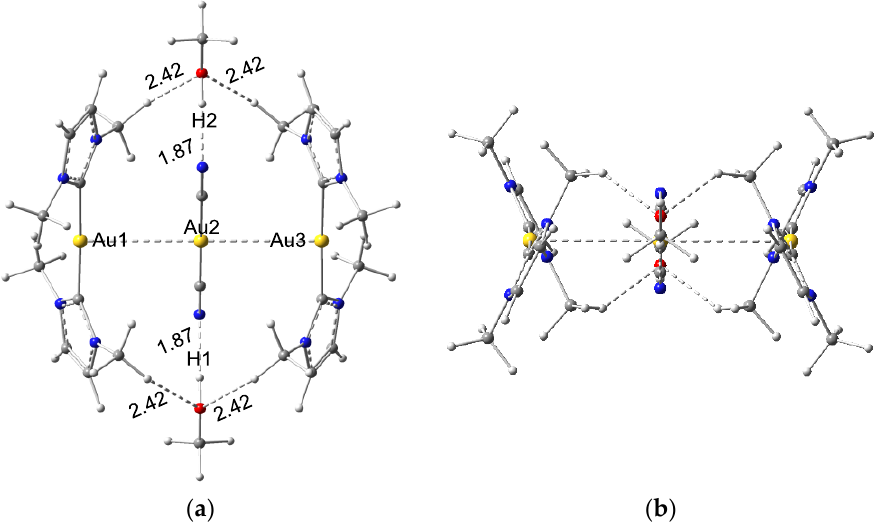
Figure 4. Top view ( a ) and side view ( b ) of the complex I ( CH 3 OH ) 2 (bond length: Å ).